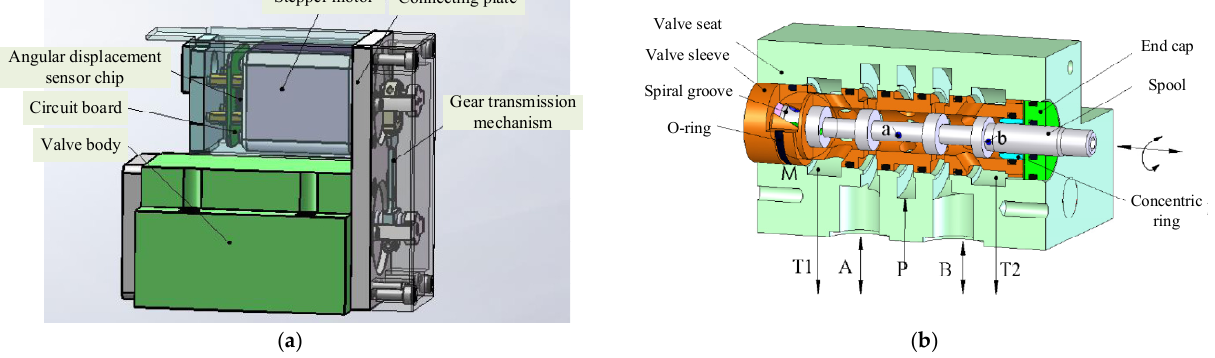
Figure 2. Structure diagram of a digital hydraulic cylinder. 1. Electrically controlled stepping mo- tor/servo motor; 2. Valve spool; 3. Nut bushing; 4. Nut; 5. Rod; 6. Screw stem.